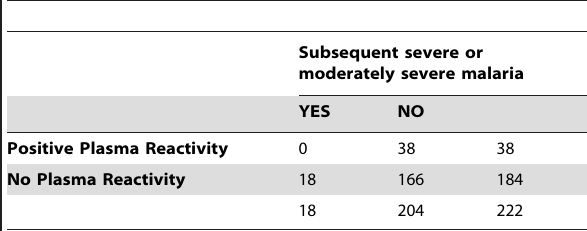
Table 2. Number of children hospitalized with subsequent severe or moderately severe malaria, stratified by Positive plasma reactivity (IgG . 0 or BI . 0) against DBL2 b C2 PF11_0521 domain measured at 76 weeks of age.